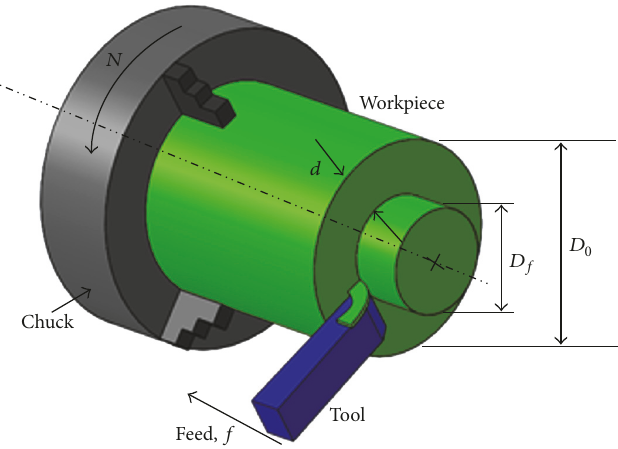
Figure 1: Example of turning